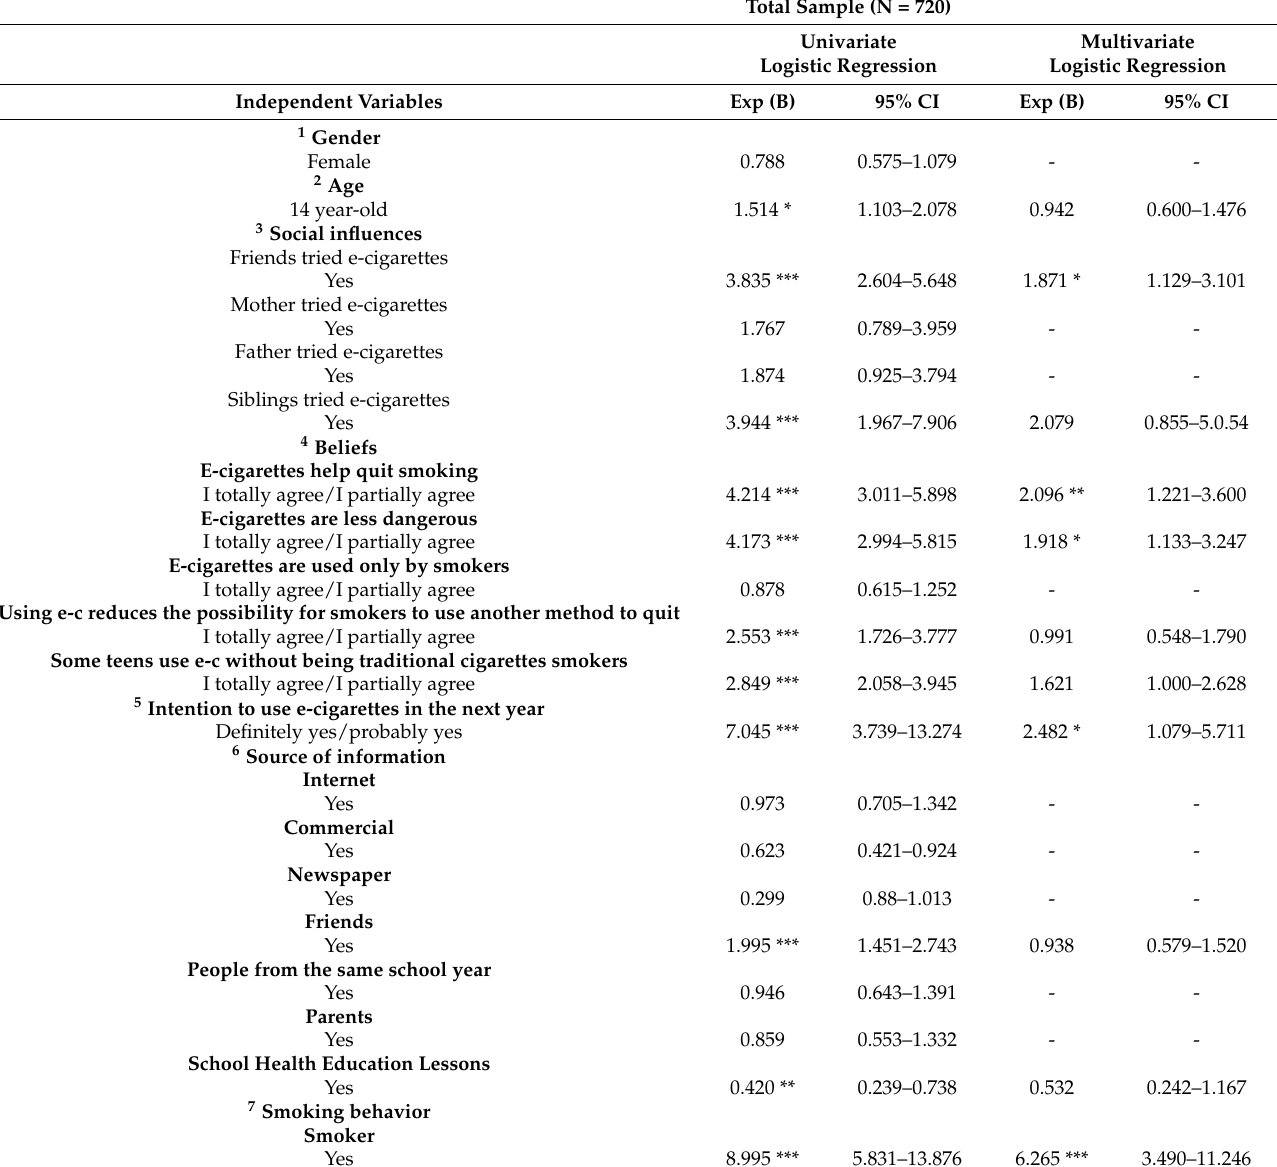
Table 3. Correlates of ever trying e-cigarettes: results of univariate and multivariate logistic regression among whole sample.